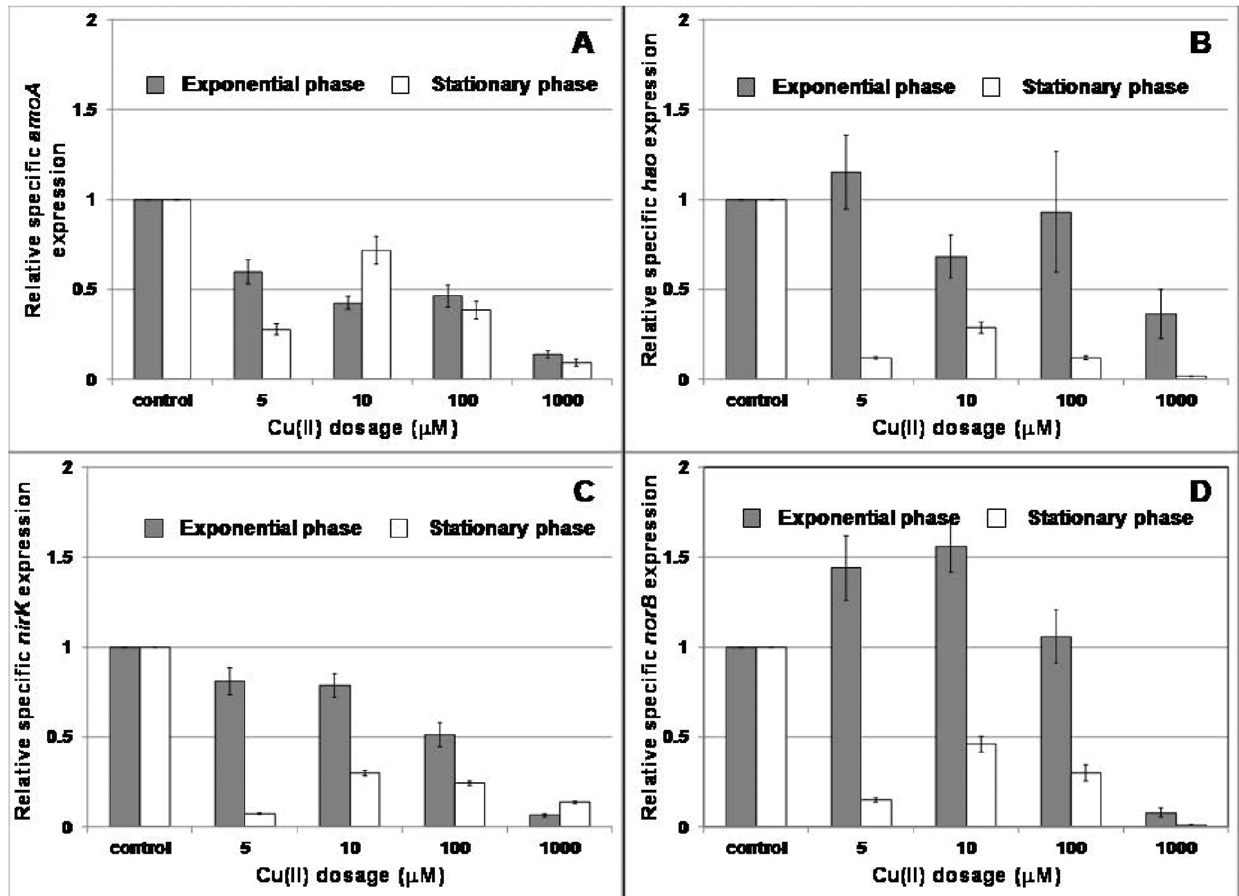
Figure 3. Impact of Cu(II) exposure on gene expression in stationary and exponential phase N.europaea cultures.